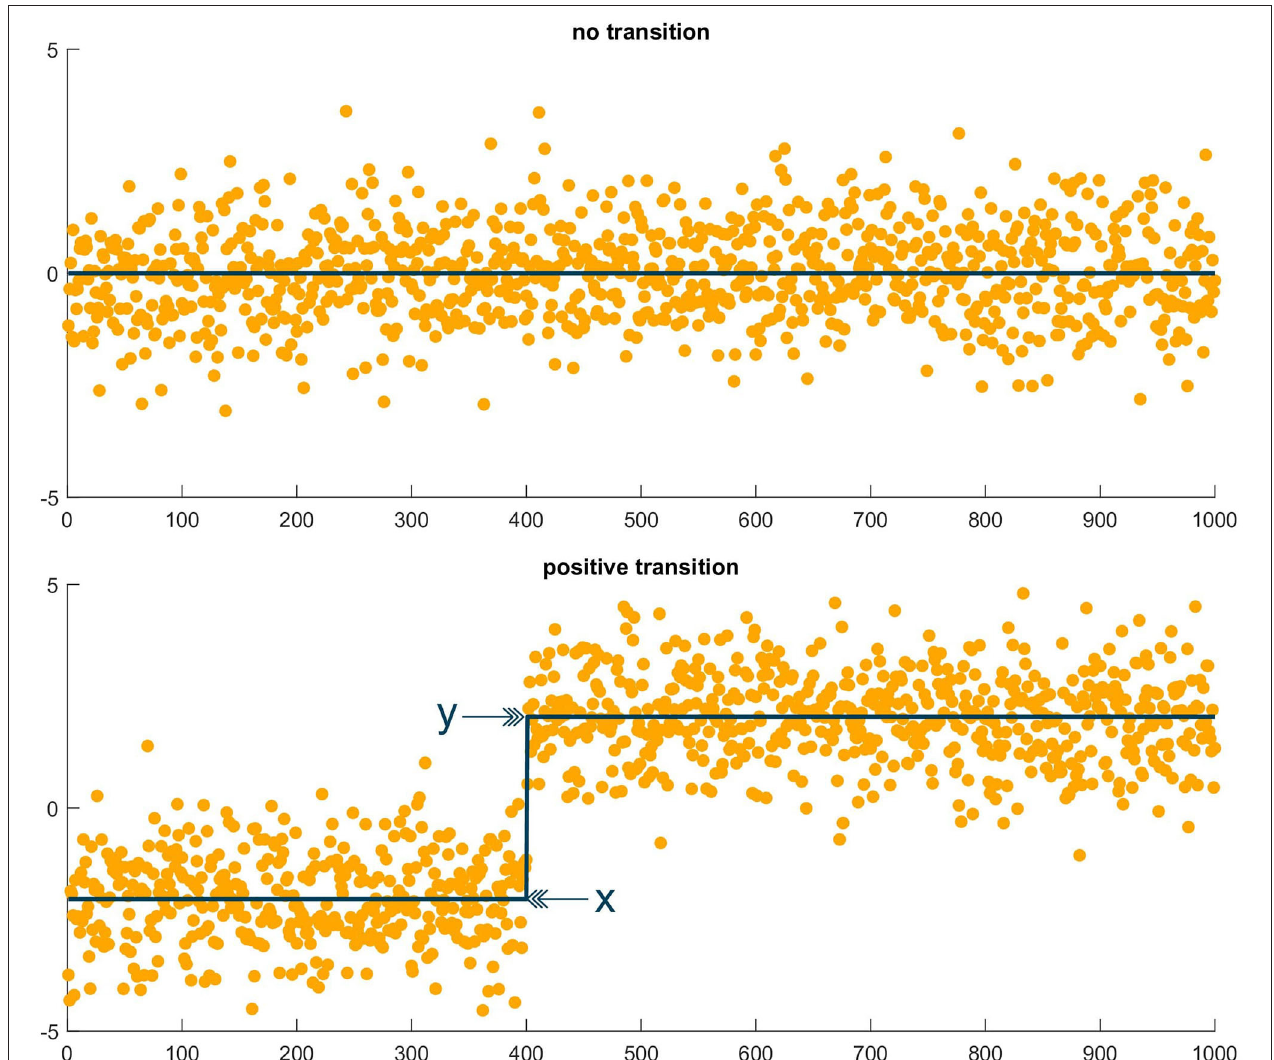
FIGURE 2 | Illustrative example of MDL test. (Top) Sequence of random values in which the MDL test found no transition. (Bottom) Sequence of random values, plus step function, in which the MDL test found a transition at the step index, with x the mean value before the transition and y the mean value after the transition.